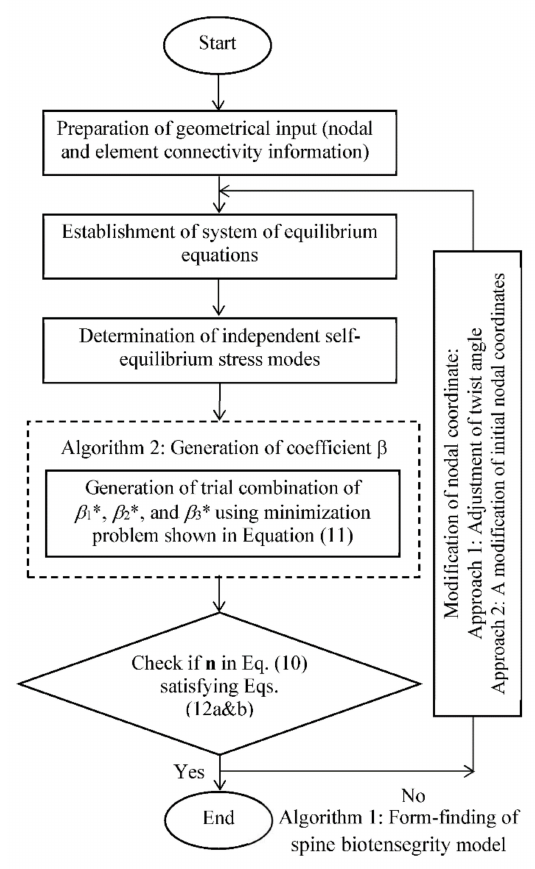
Figure 9. Algorithm for form-finding of spine biotensegrity model.